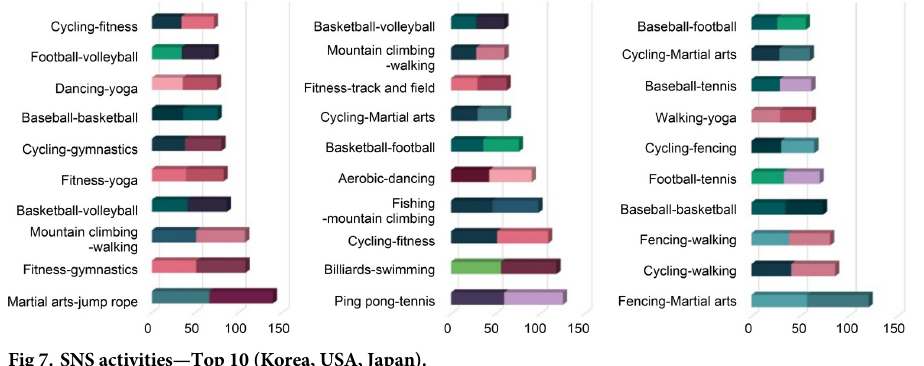
Fig 7. SNS activities—Top 10 (Korea, USA, Japan).